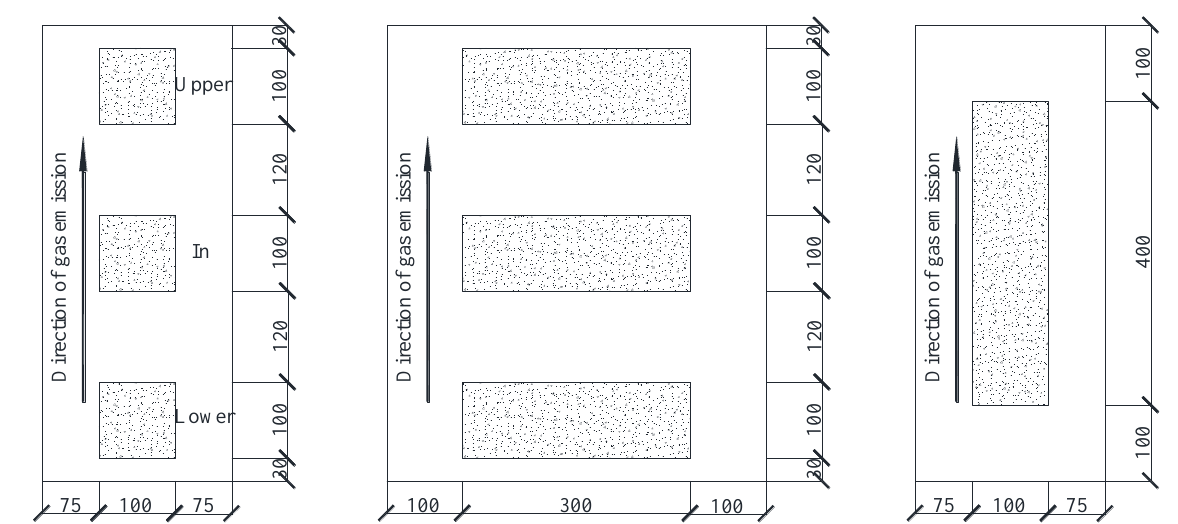
Figure 1. Sawing diagram of AAC specimen. (Units in mm).